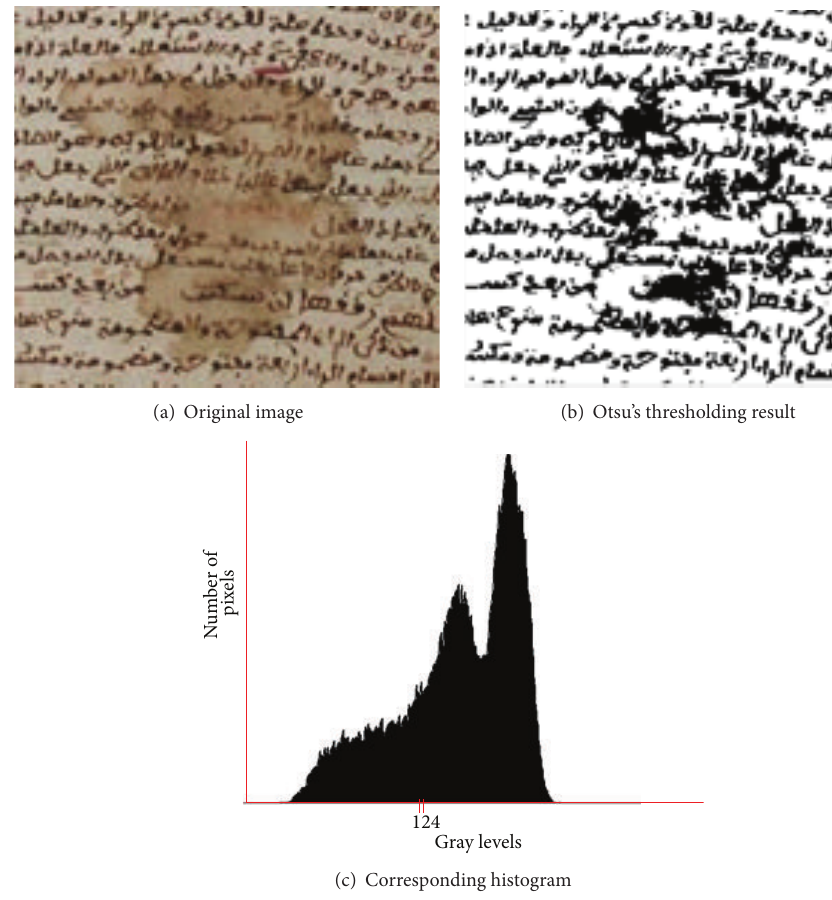
Figure 2: Global thresholding of degraded